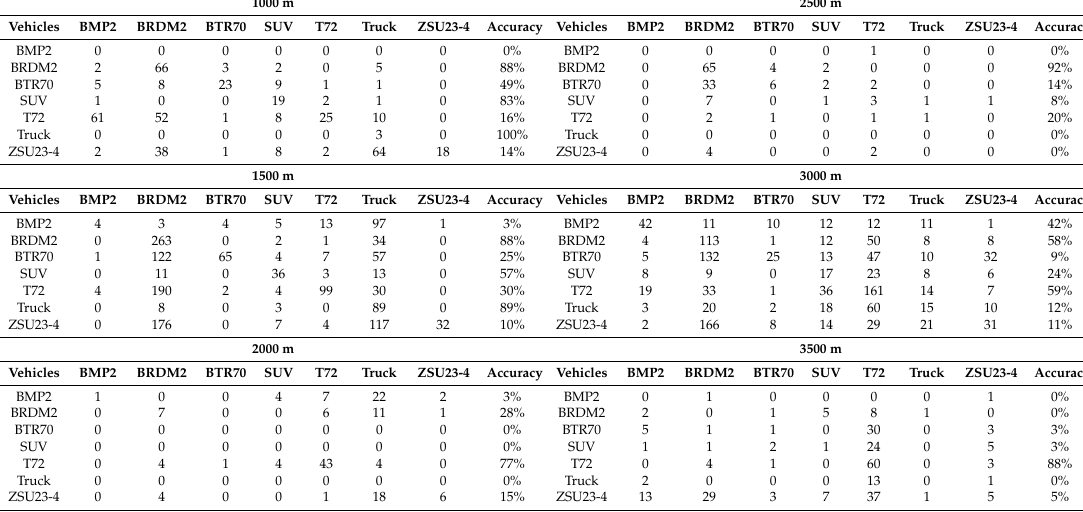
Table A7. Classification results for PCE 50 case (MWIR daytime) case. Left shows the confusion matrix and the last column shows the classification